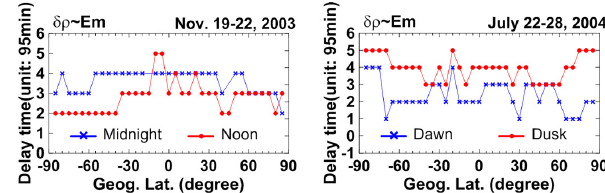
Fig. 9. Latitudinal variation of delay time of mass density changes with E m for different LT sectors during magnetic storms of 19– 22 November 2003 (left) and 22–28 July 2004 (right).